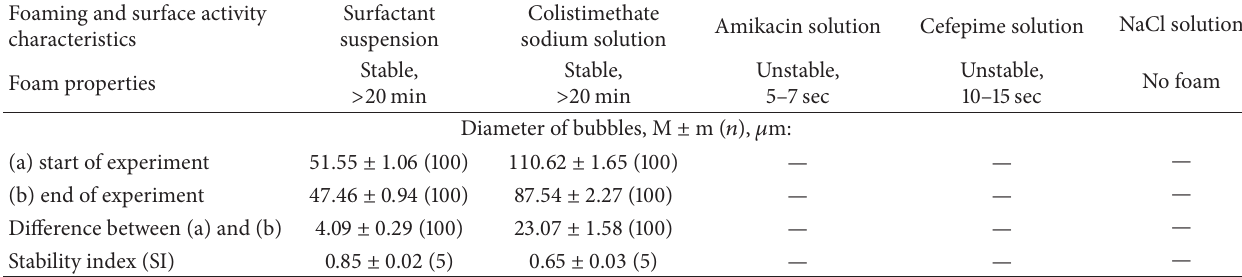
Table 1: Foaming properties and stability index values for original preparations. Foaming and surface